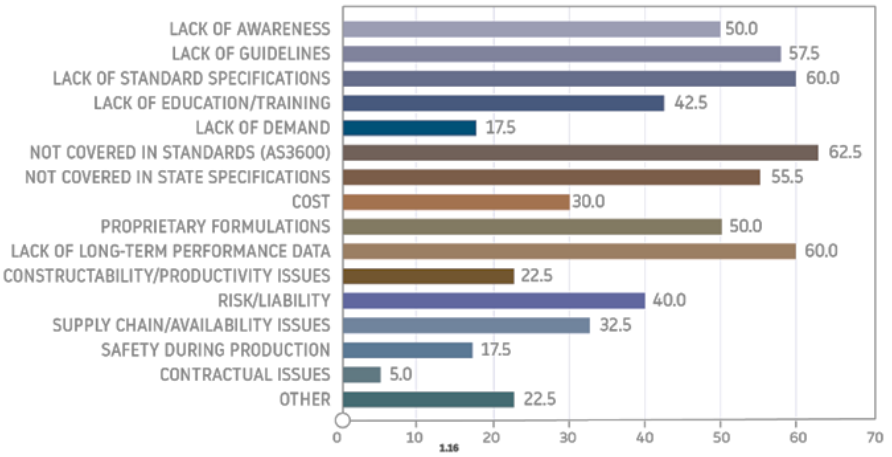
Figure 6. Respondents’ responses regarding barriers to geopolymer implementation [69].